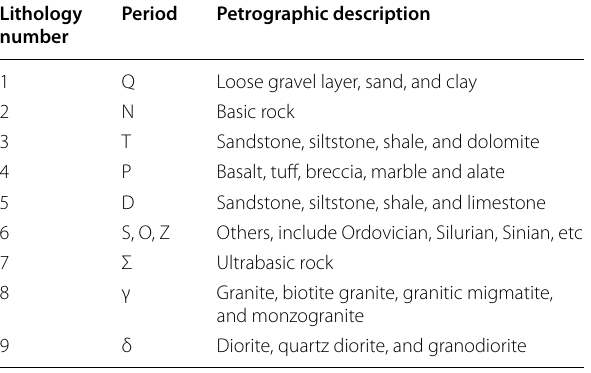
Table 1 Descriptions of categorized lithology in the study area Lithology number